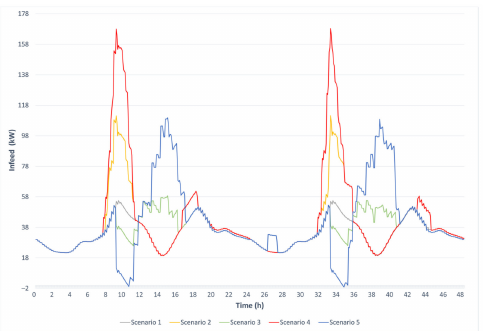
Figure 6. The comparison of infeed power in all